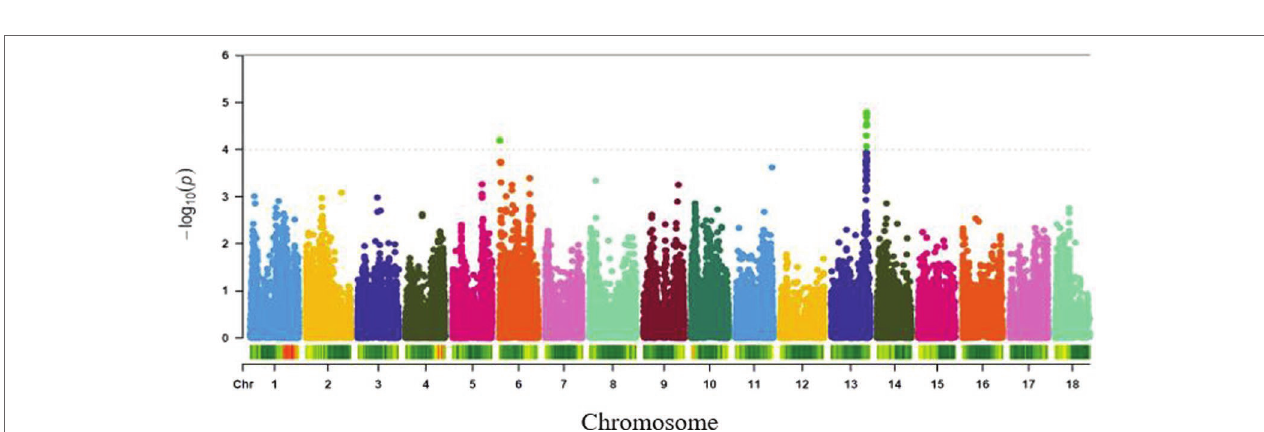
FIGURE 4 | Manhattan plot for GWAS based on best linear unbiased predictions for root mealiness. The dashed horizontal line depicts the genome-wide significance